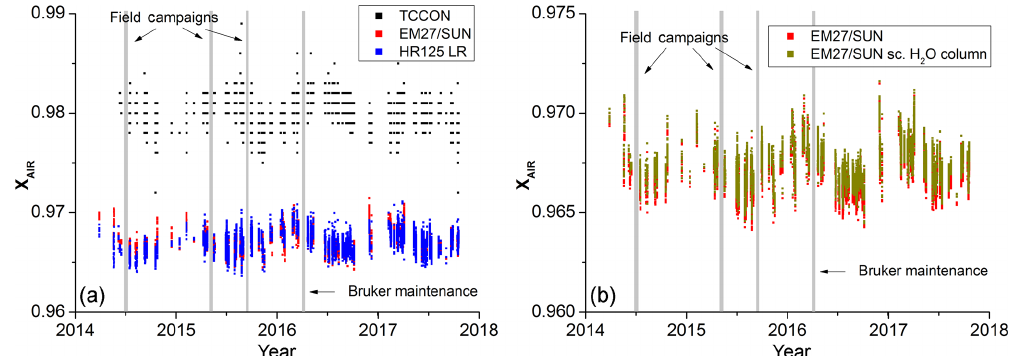
Figure 3. (a) shows the X air time series measured at KIT in Karlsruhe for the TCCON, EM27/SUN and HR125 LR data sets. For clarity, only coincident measurements (within 1min) of the data sets are plotted. Grey areas denote periods where the EM27/SUN was moved over long distances. (b) shows a comparison of the original EM27/SUN time series with a modified version, where a scaling factor of 0.8 was applied to the H 2 O total column.